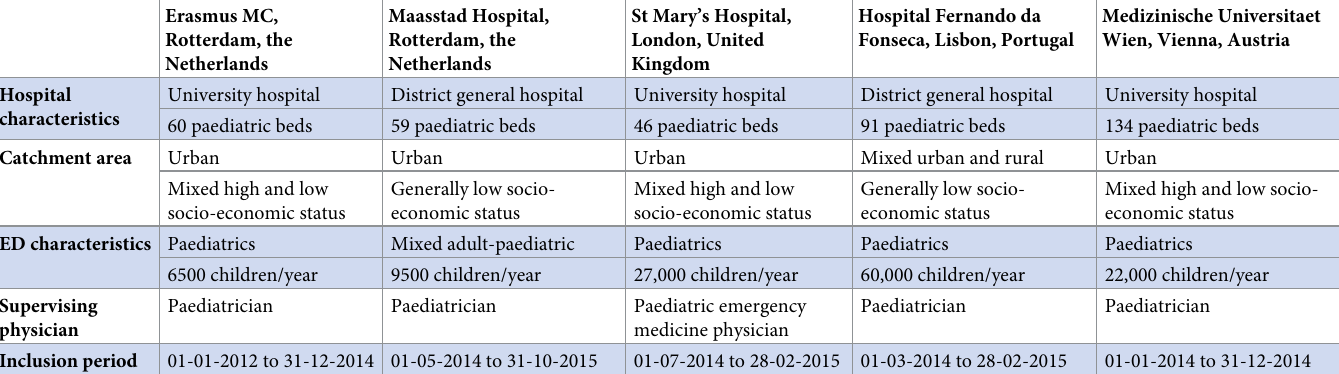
Table 1. Overview of the participating